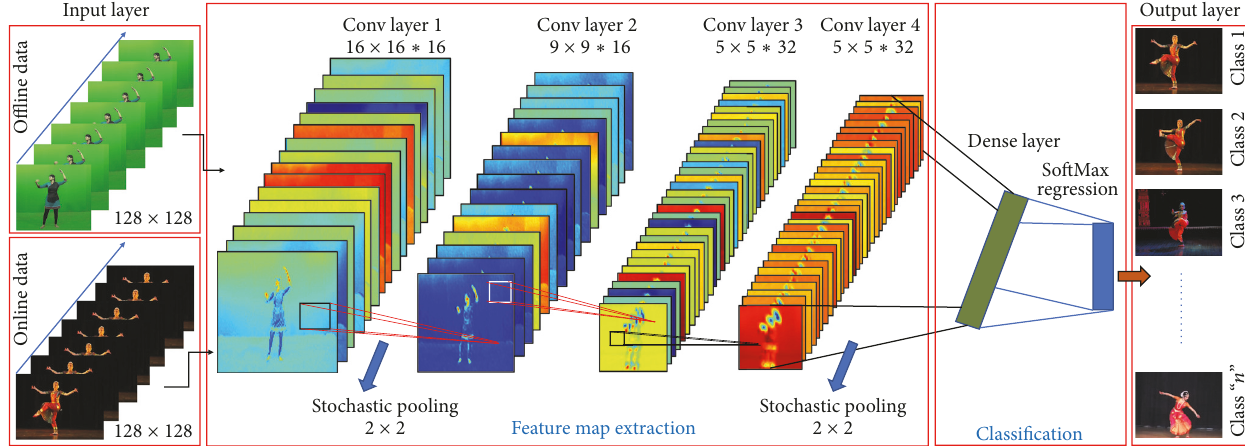
Figure 2: The proposed Deep CNN